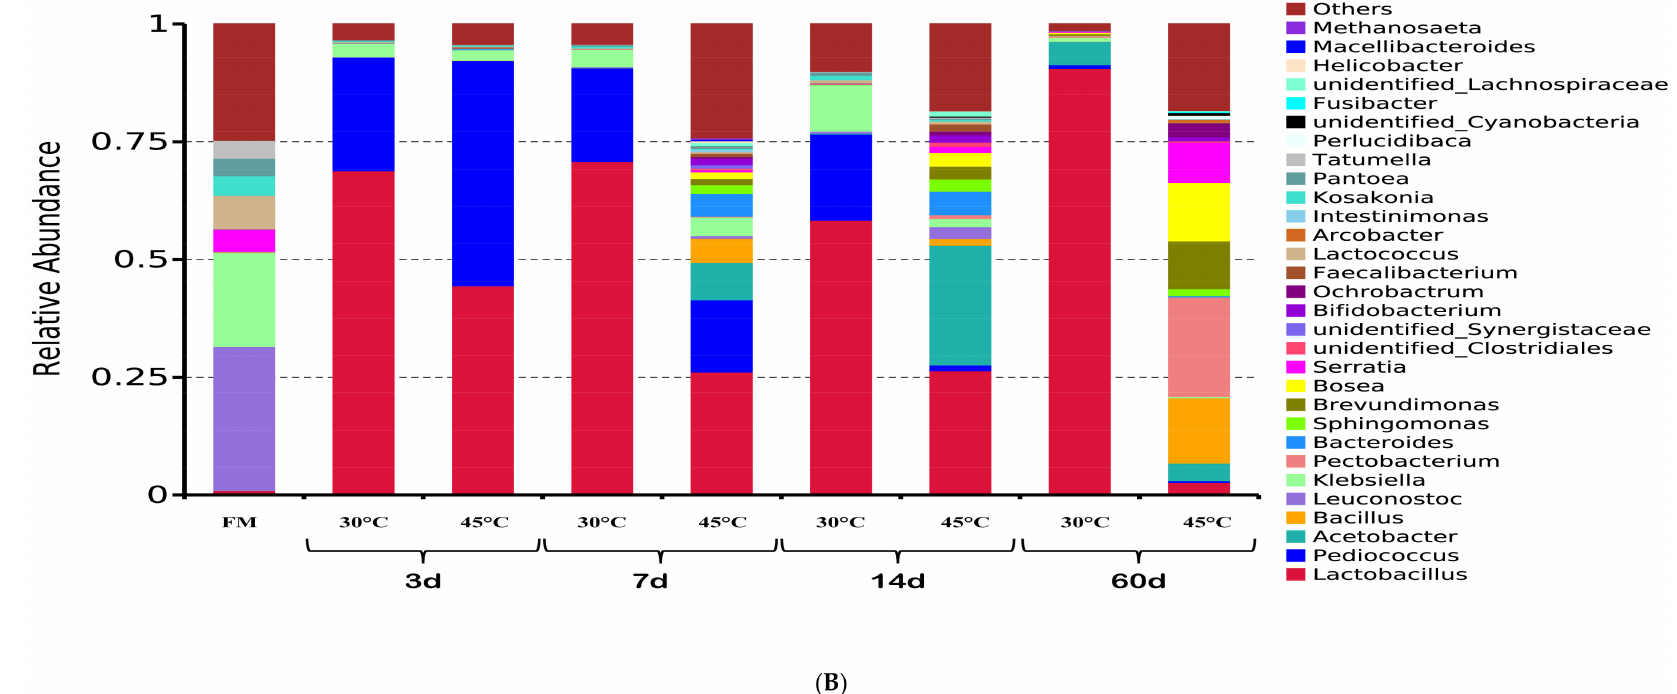
Figure 2. Taxonomic profile of the bacterial core microbiome varied among fresh forage and dynamic changes of corn silages at two temperatures at the genus level. ( A ) The relative abundance of the bacterial microbiome in every sample before and after ensiling; ( B ) Average values of silage samples for every period (FM: fresh material; 3 d; 7 d; 14 d; 60 d). Note: CK = Control; LS358 = Lactobacillus salivarius 358; LR753 = Lactobacillus rhamnosus 753; LS = Lactobacillus salivarius ATCC 11741; LR = Lactobacillus rhamnosus ATCC